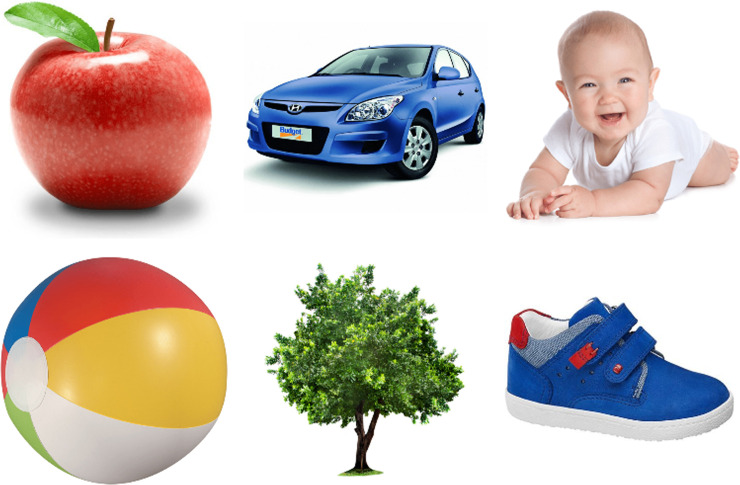
Familiar objects.